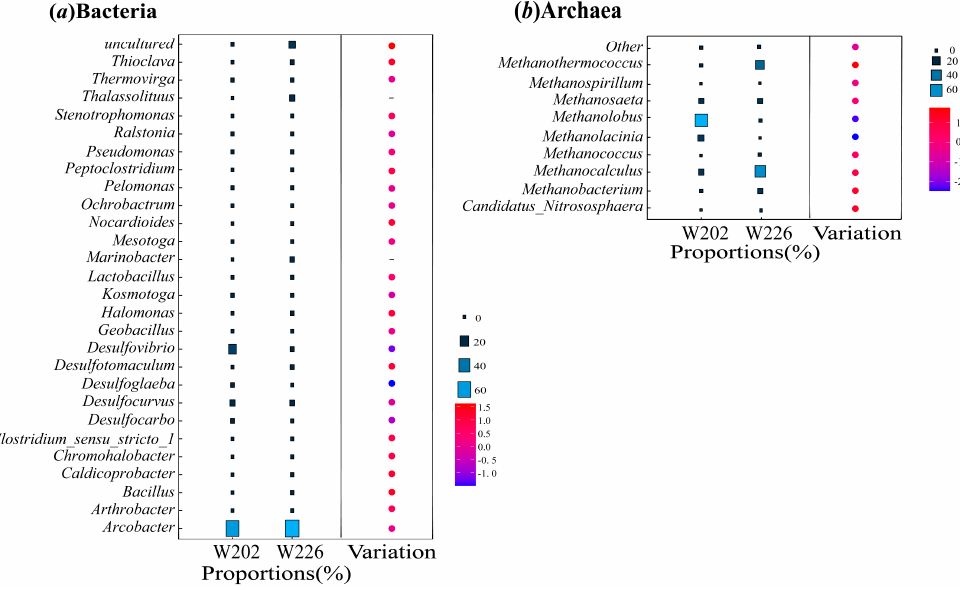
Figure 5. Comparative bacterial ( a ) and archaeal ( b ) community analysis of the production and control well at the genus level. The analysis was conducted among the genera with the abundance of more than 1%. Data were analysed using the results from triplicate independent experiments by t -test. p values less than 0.05 were considered significant. Table 4. Enumeration of functional microorganisms in oil reservoirs. Well